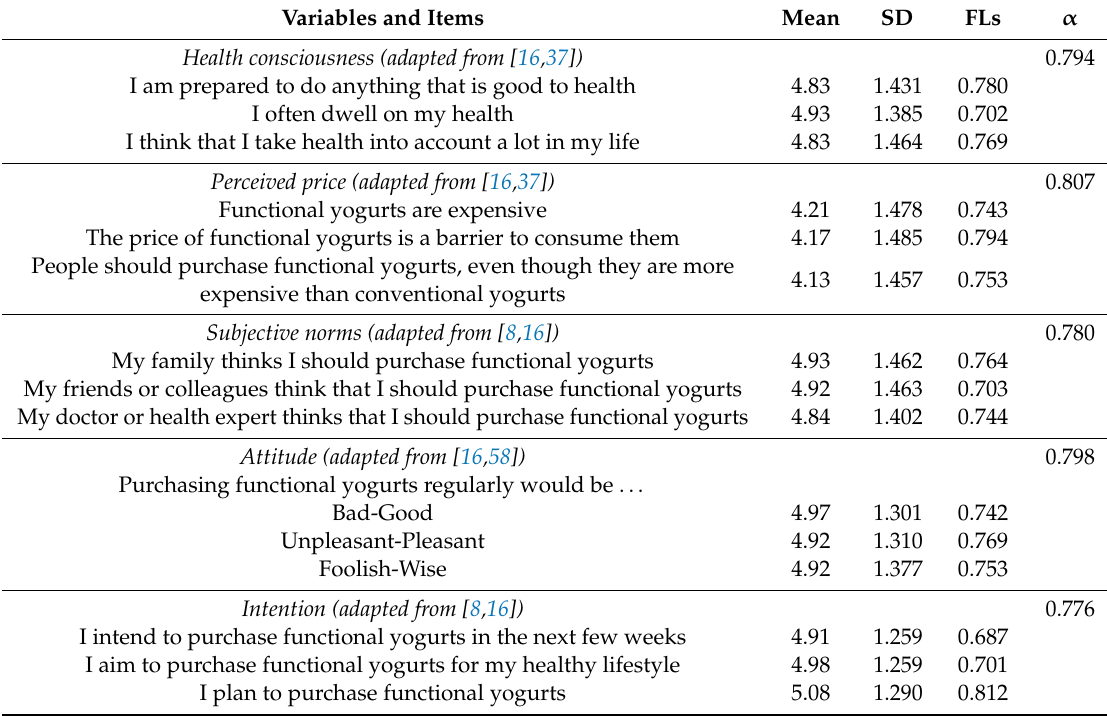
Table 2. Constructs, items, and properties.